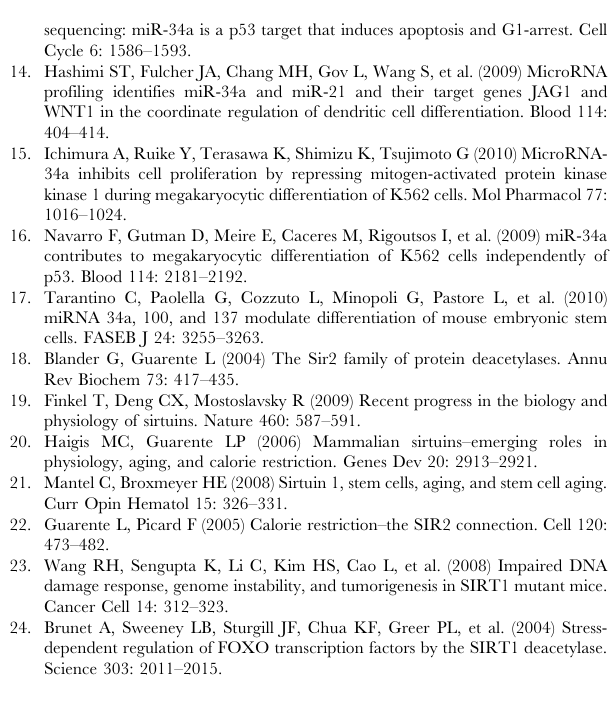
Table S1 Sequence of oligonucleotides used in EMSA assay. p53 binding motifs are shown in bold. p53 –cons, p53 consensus oligonucleotide; p53-cons-mut, oligonucleotide bearing a mutation in the consensus site; p53A and B, oligonucleotides containing either two or one quarter-sites known to be